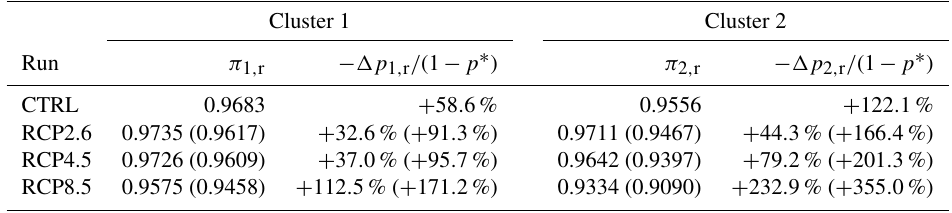
Table 1. Change in frequency of cold-spell analogues for each of the considered events, divided by cluster. The values corresponding to the RCPs are adjusted by subtracting the values relative to the CTRL run, which quantify PlaSim’s bias in analogues frequency; unadjusted values are shown in parentheses.